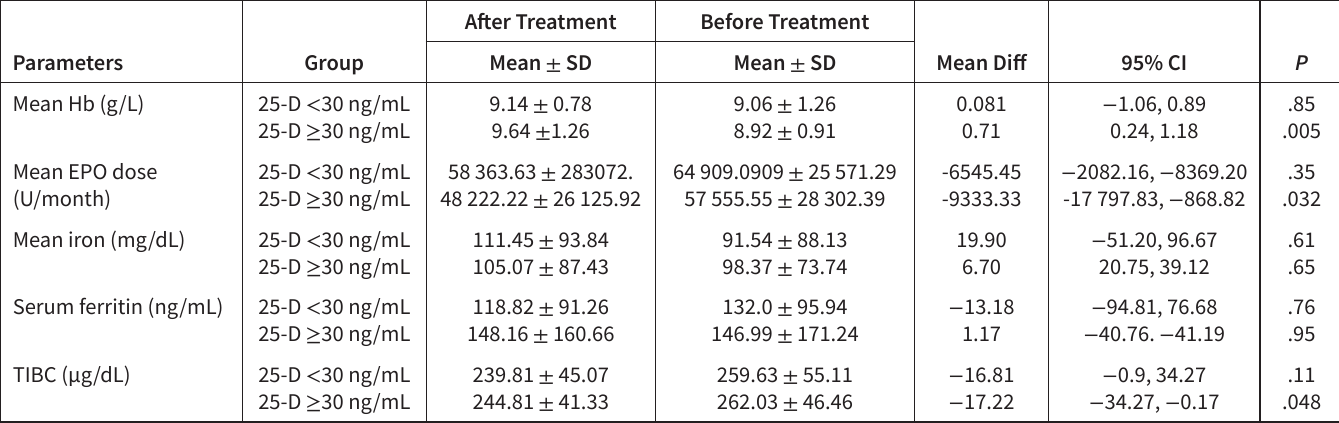
Table 2. Erythropoietin Dose and Laboratory Parameter in Responders and Non-responders Groups Before and After 3 Months of Ergocalciferol Supplementation in Study Patients